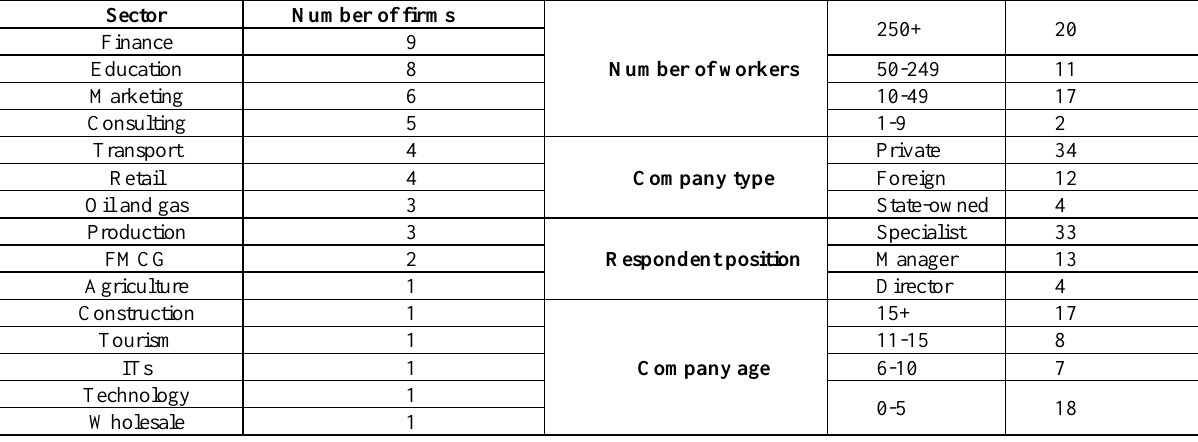
Table 1. Categorization of the survey data.